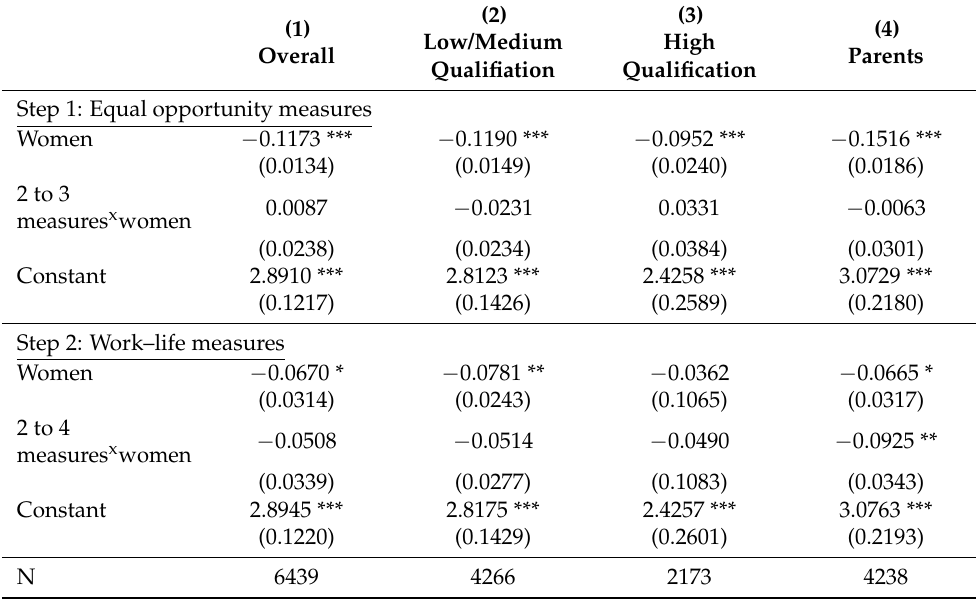
Table 4. The association of multiple equal opportunity/work–life measures and log hourly wages (multi-level linear regression models with organizational fixed effects).